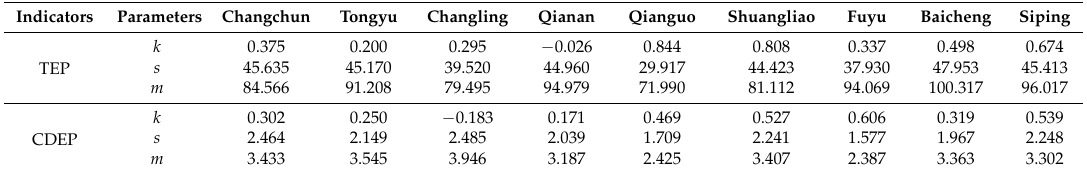
Table 3. The fitting parameters for the marginal distribution of the flood indicators.